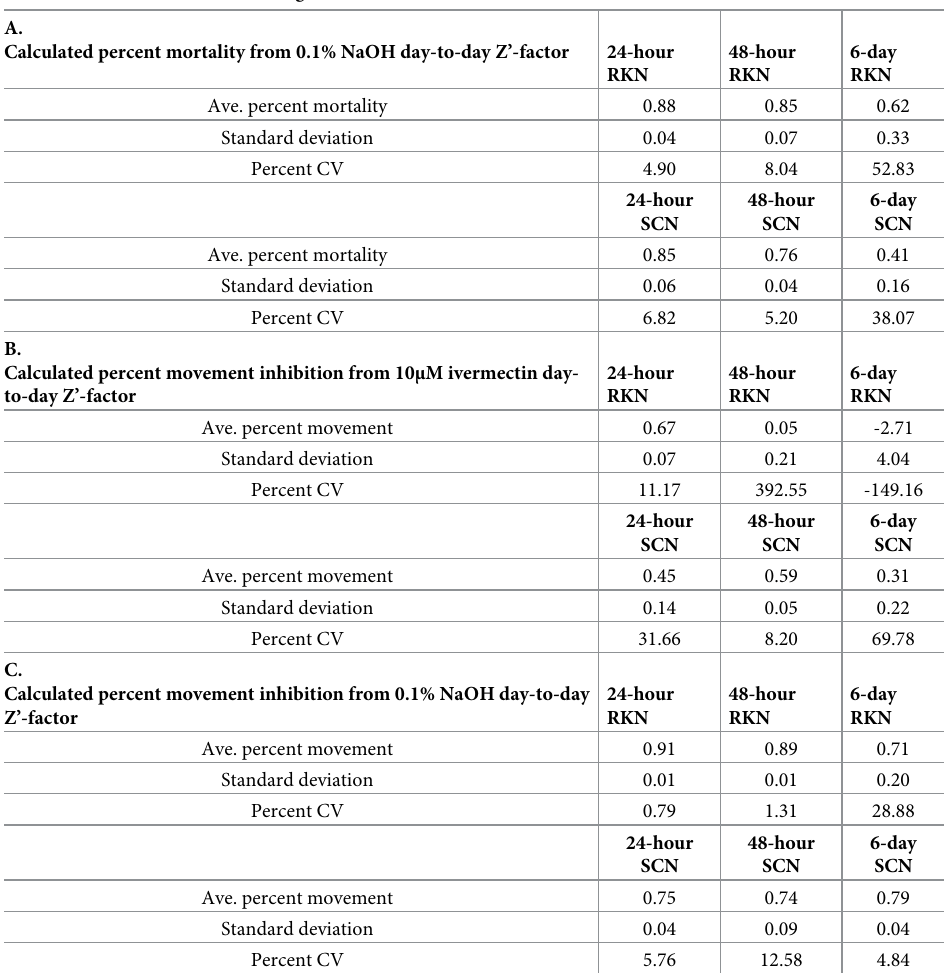
Table 2. Calculated Z’-factor testing results.